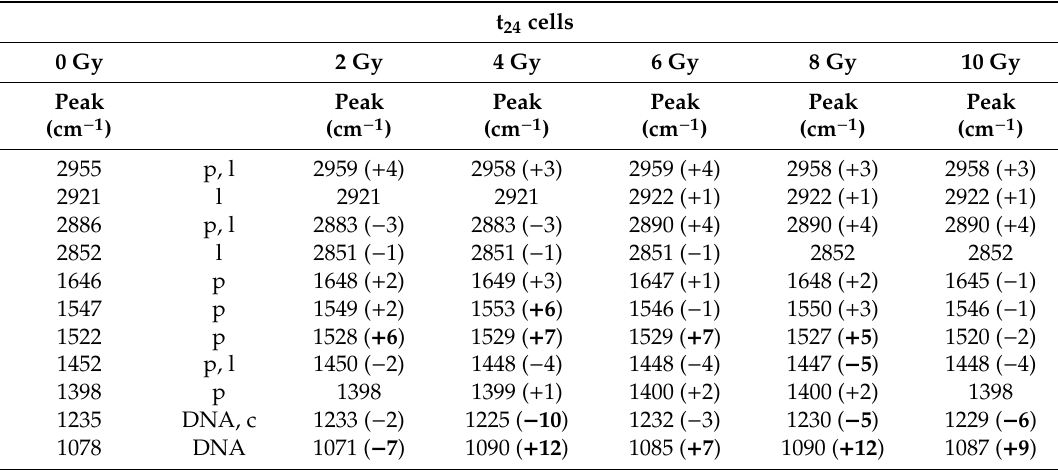
Table 3. Average FTIR peak positions for control and samples treated with di ff erent doses of X-rays fixed 24 h after irradiation. The shifts in terms of units of wavenumber are indicated in brackets for the 0 Gy spectrum stands for shifts with respect to the values found for the control spectrum (t0); bold values stand for shifts greater than the spectral resolution of the instrument 4 cm − 1 . Abbreviations: p = proteins, l = lipids, c =